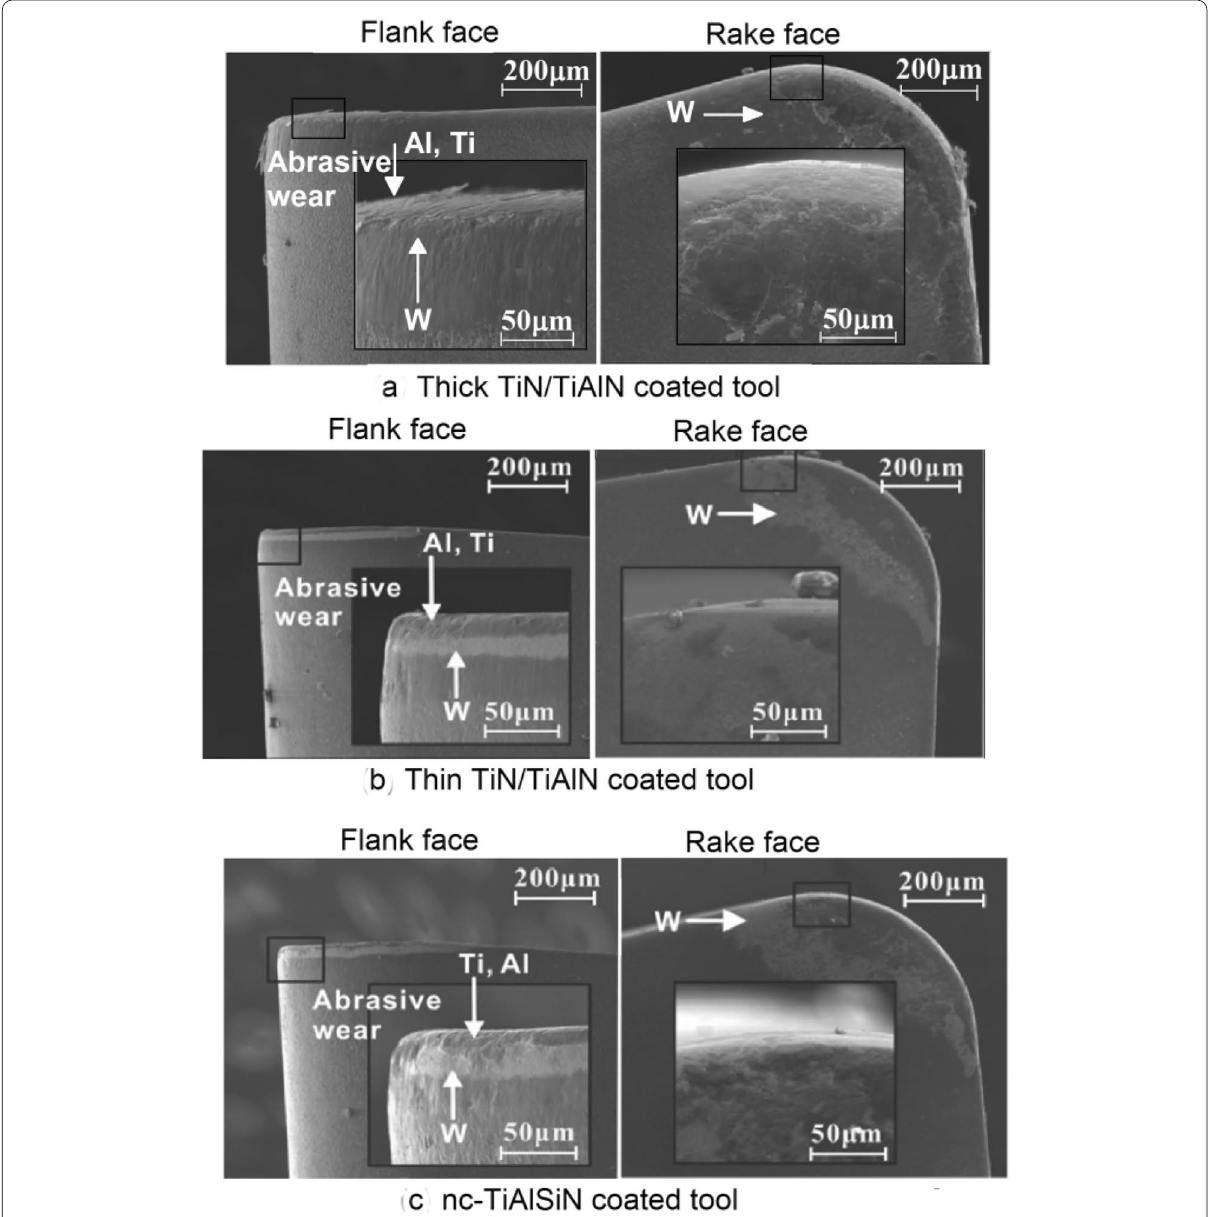
Figure 9 Tool wear morphologies of the three coated tools in dry turning of CGI ( v